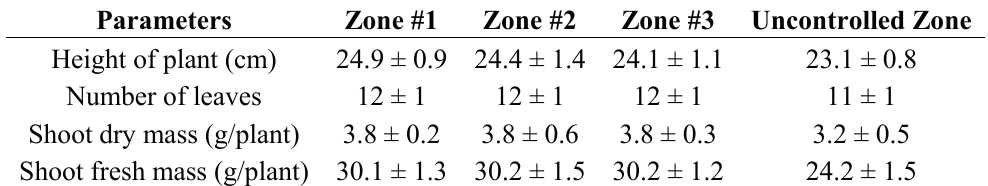
Figure 14. Variations in plant growth patterns: ( a ) LAI versus DAS; ( b ) number of leaves versus DAS; ( c ) cumulative amount of light versus DAS. Table 6. The tissue analysis of Lettuce under different growth